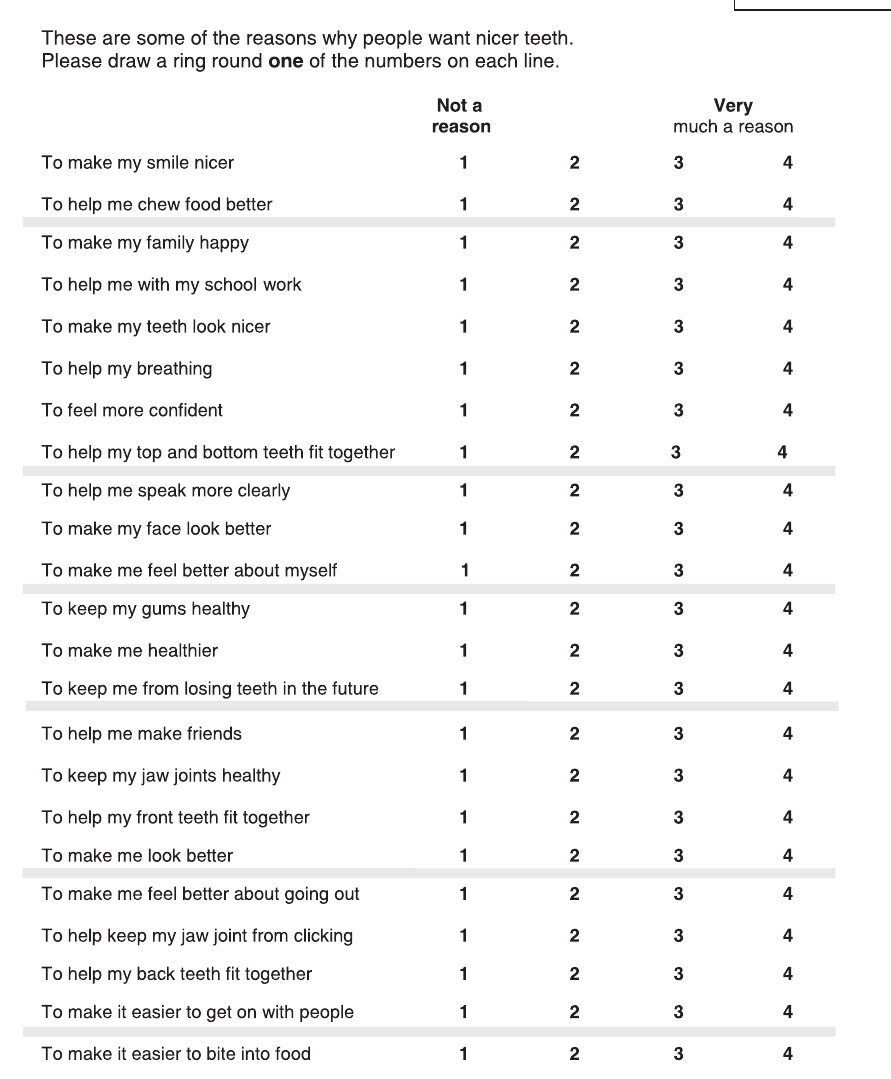
Figure 3. Participants assessments of their